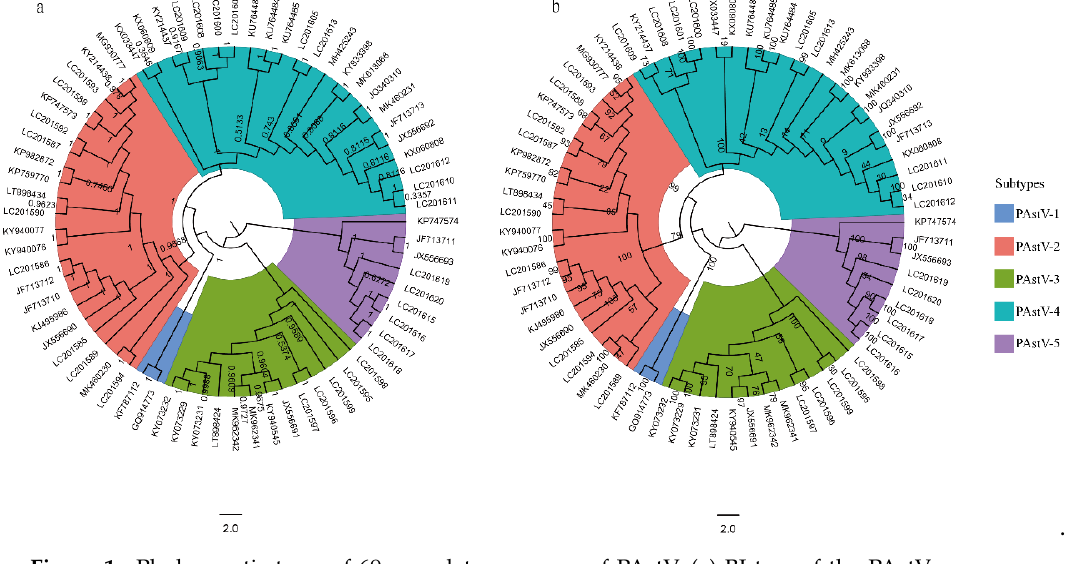
Figure 1. Phylogenetic trees of 69 complete genomes of PAstV. ( a ) BI tree of the PAstV genomes reconstructed by MrBayes. Posterior probability values are shown at each node. ( b ) ML tree of the PAstV genomes reconstructed by RAxML. Bootstrap support values are indicated on the tree as a percentage of 10,000 replicates. The colored circular sectors indicate the five subtypes of PAstV.